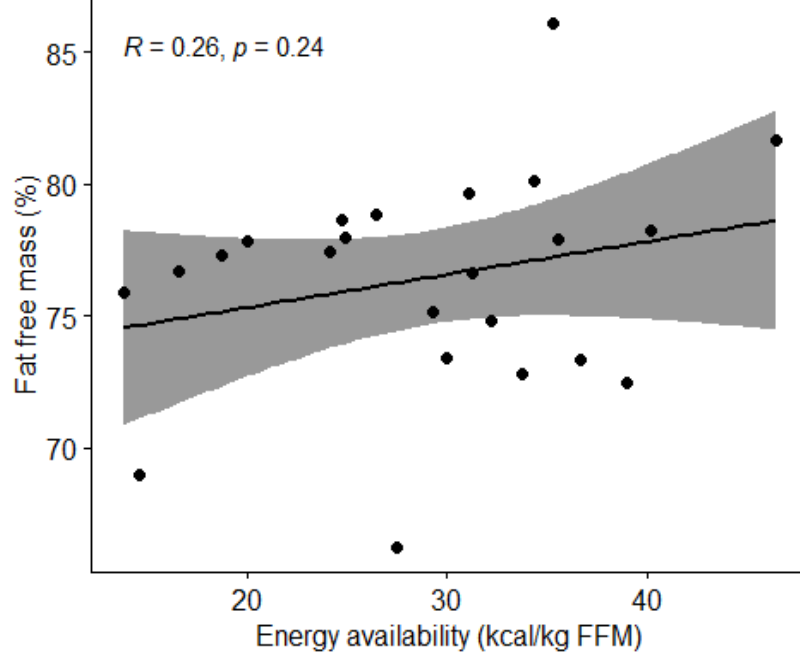
Figure 7. Correlation between energy availability and percentage of lean body mass in football players. Dots represent individual participants ( n = 23). Grey shaded area indicates 95% CI.